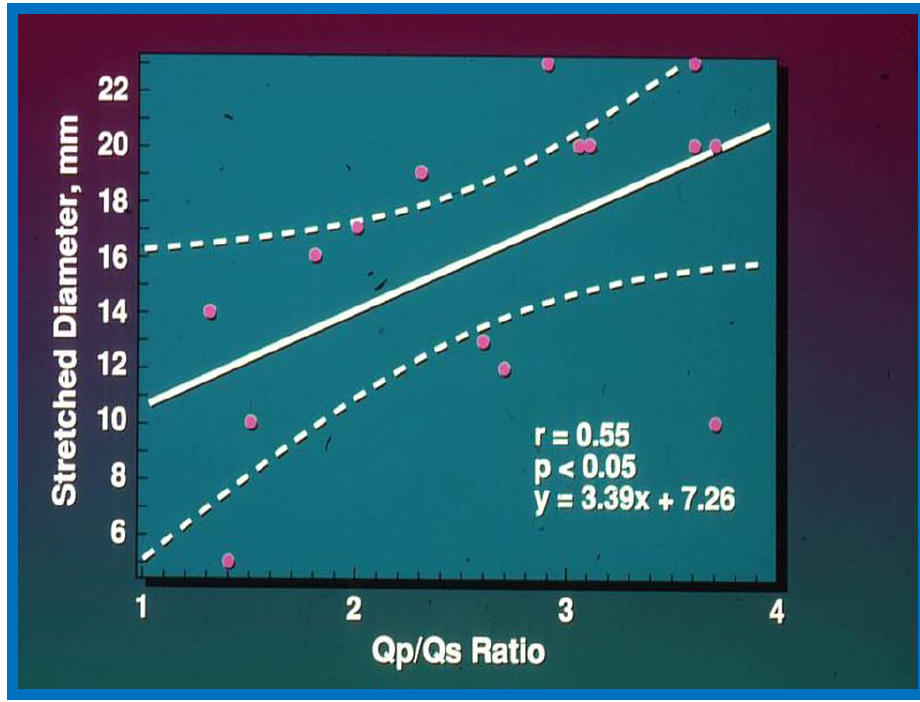
Figure 1. The relationship between pulmonary to systemic flow ratio (Qp/Qs) and stretched diameter of the atrial septal defect is plotted. Regression line (solid line) along with 95% confidence lines (interrupted lines) is shown. Note significant ( p < 0.05) correlation with an r value of 0.55. Reproduced from Rao P.S., et al. [2].